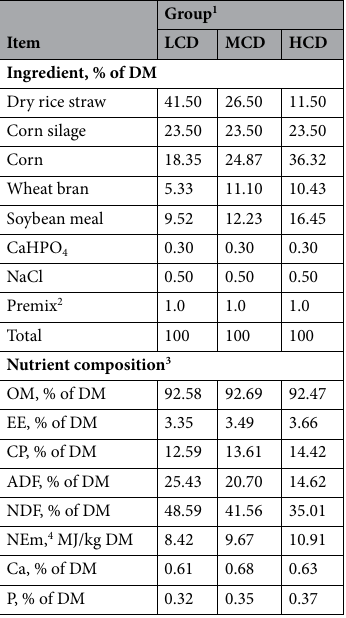
Table 1. Dietary ingredients and chemical composition (g/kg DM). 1 LCD, 35:65 concentrate:forage; MCD, 50:50 concentrate:forage; HCD, 65:35 concentrate:forage; 2 Premix contained (per kg of premix): 420,000 IU of vitamin A, 110,000 IU of vitamin D 3 , 4,200 IU of vitamin E, 2620 mg of Fe, 155 g of Ca, 30 g of P, 820 mg of Cu, 1,800 mg of Mn, 3,500 mg of Zn, 30 mg of I, 35 mg of Se, and 22 mg of Co. 3 OM, organic matter; EE, ether extract; CP, crude protein; NDF, neutral detergent fiber; ADF, acid detergent fiber; NEm, net energy for maintenance; Ca, calcium; P, phosphorus. 4